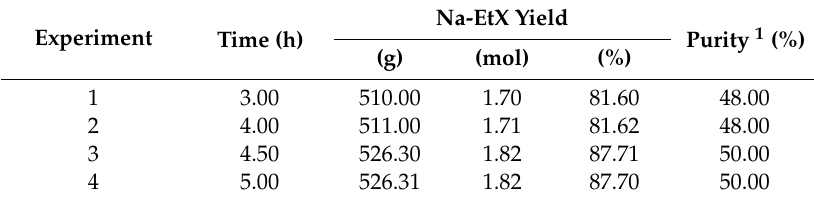
Table 1. Dependence of Na-EtX yield versus reaction time (reaction conditions: temperature: I reaction